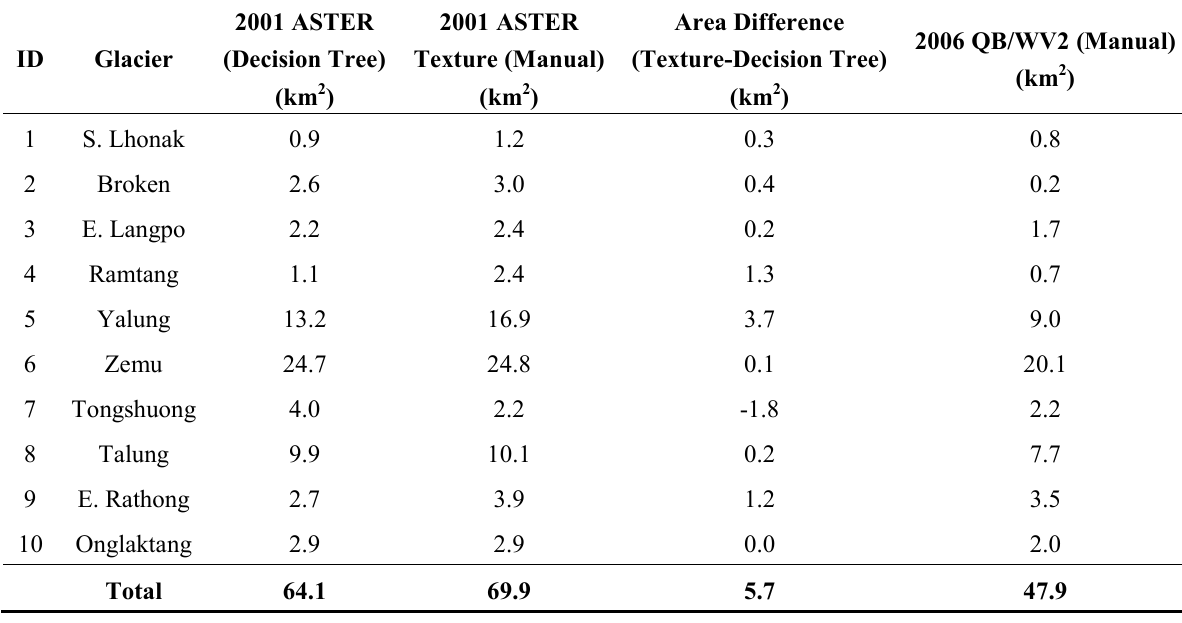
Table 3. Comparison between the debris-covered areas based on ASTER decision tree with manually digitized areas from QB/WV2 and the ASTER texture analysis for the ten selected glaciers. Kangchenjunga glacier (#11) and Umaram Kang glacier (#12) were not included here because they were in shadow and under cloud cover,